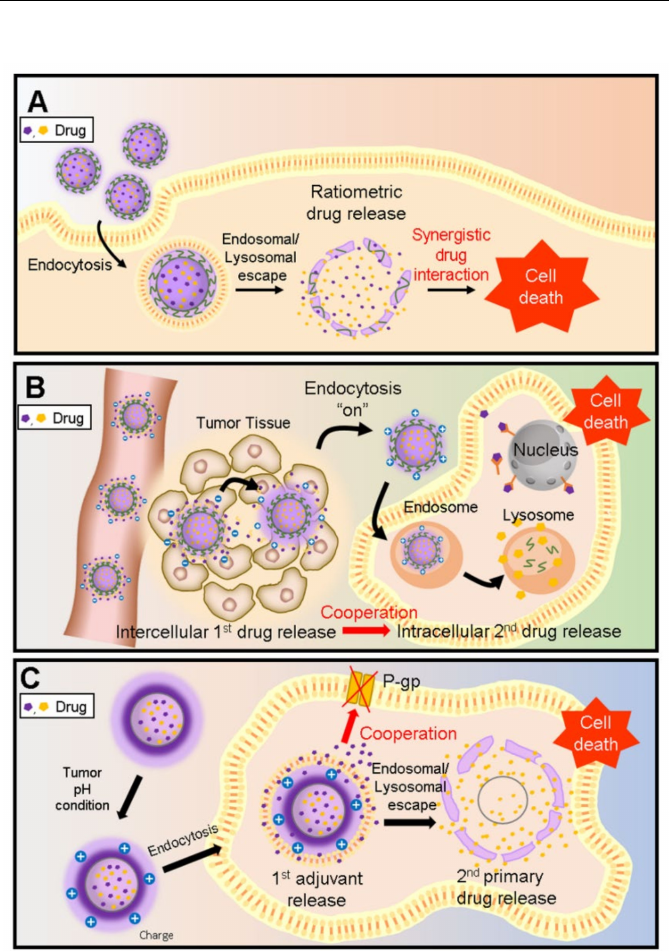
Figure 1. Schematic illustration of various spatiotemporal types of combinatorial anticancer drug release. ( A ) Ratiometric drug delivery and simultaneous release for synergistic drug interaction. ( B ) Sequential drug release to achieve both intercellular and intracellular drug action. ( C ) Intracellular sequential release of adjuvant and primary drug for enhanced drug e ffi